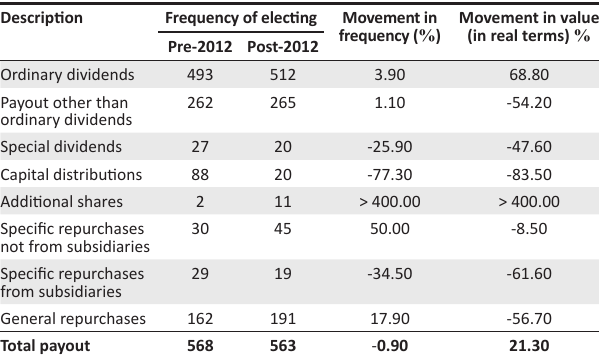
TABLE 3: Frequency of electing only one payout method or more than one payout method. Description